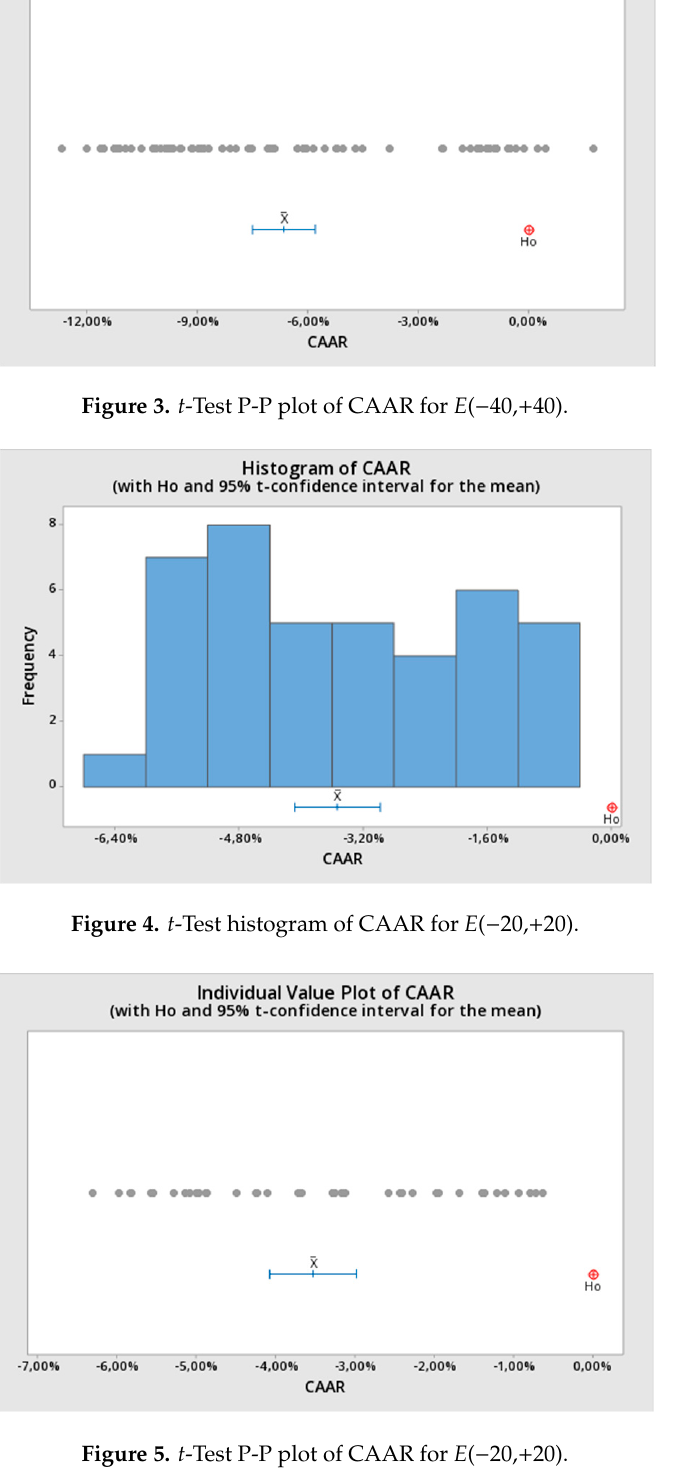
Figure 5. t -Test P-P plot of CAAR for E ( − 20,+20) .